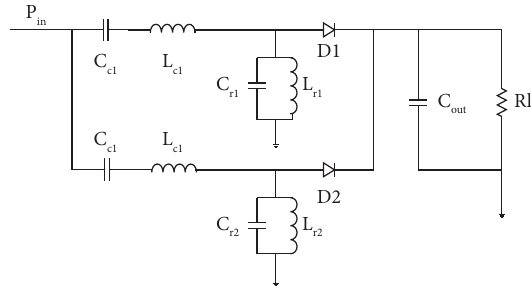
Figure 23: Rectifer of two branch adopting the frst branch.